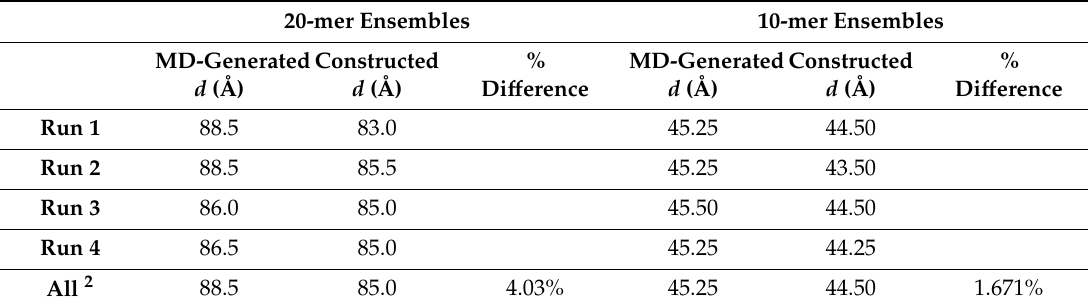
Figure 10. End-to-end distance probability distribution of MD-generated (blue dashed lines) and Figure 10. End ‐ to ‐ end distance probability distribution of MD ‐ generated (blue dashed lines) and constructed (red solid lines) 10-mer ensembles; each type of ensemble includes four sets of 10,000 constructed (red solid lines) 10 ‐ mer ensembles; each type of ensemble includes four sets of 10,000 conformations; probabilities were calculated for end-to-end distances sorted into 0.25 Å bins. conformations; probabilities were calculated for end ‐ to ‐ end distances sorted into 0.25 Å bins. Table 2. Most Probable End-to-End Distances ( d ) in MD-Generated and Constructed Ensembles 1 Table 2. Most Probable End ‐ to ‐ End Distances ( d ) in MD ‐ Generated and Constructed Ensembles 1